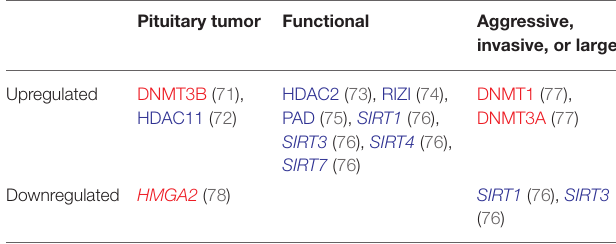
TABLE 3 | Altered regulation of epigenetic modifiers in aggressive, invasive, or large, and functional